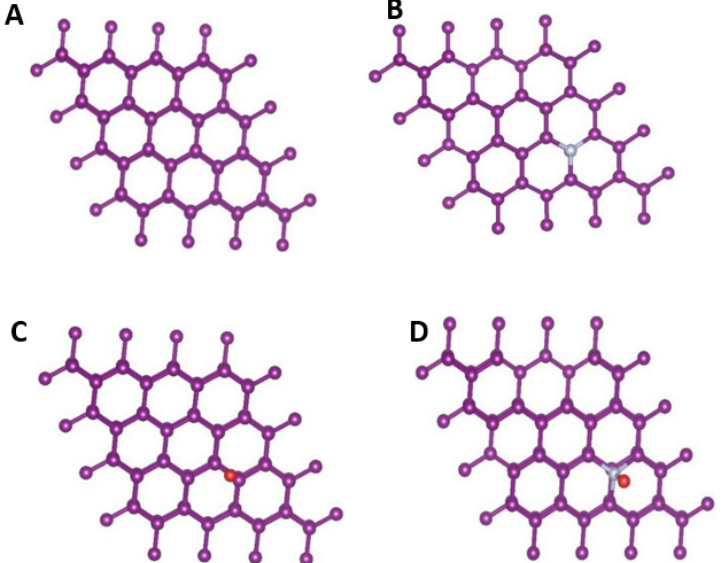
Figure 9. The optimized structures of graphite bilayers: ( A ) pristine graphite, ( B ) graphite substituted with a N atom on the surface, ( C ) pristine graphite with O adsorbate, and ( D ) graphite substituted with a N atom and O adsorbate. The figures were plotted using the VESTA software. The color code of the atoms is as follows—purple: C, white: N, red: O.